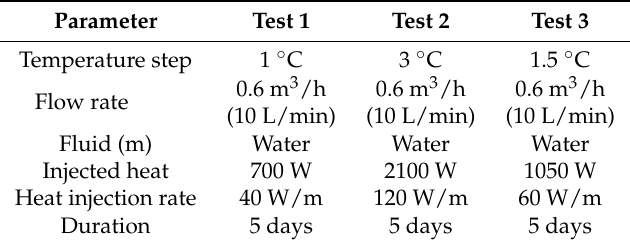
Table 2. Thermal response test